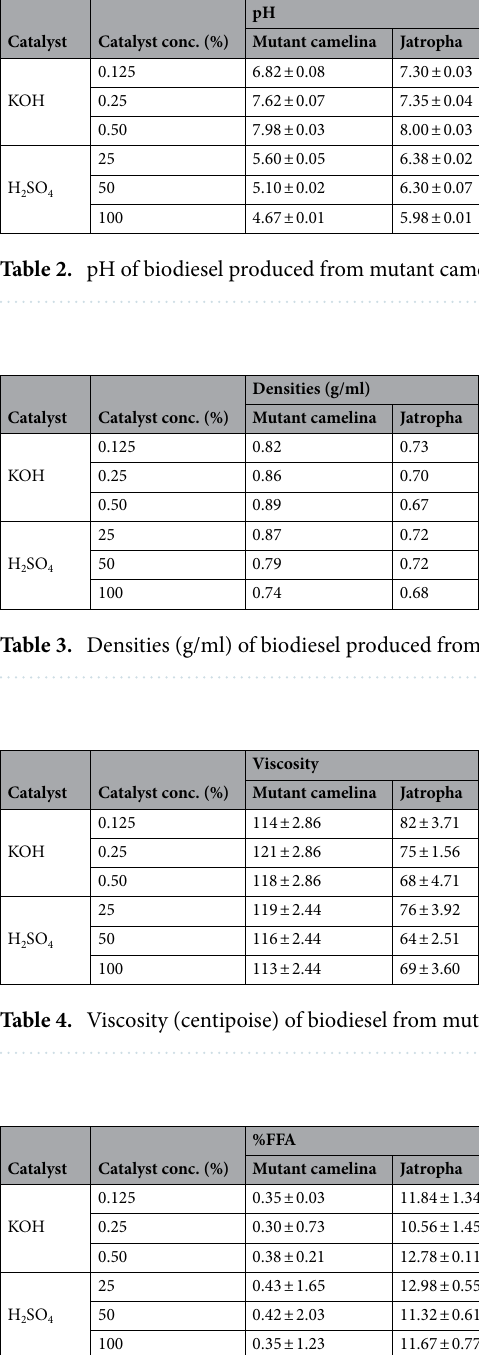
Table 5. Free Fatty acids in biodiesel produced from mutant camelina and jatropha.